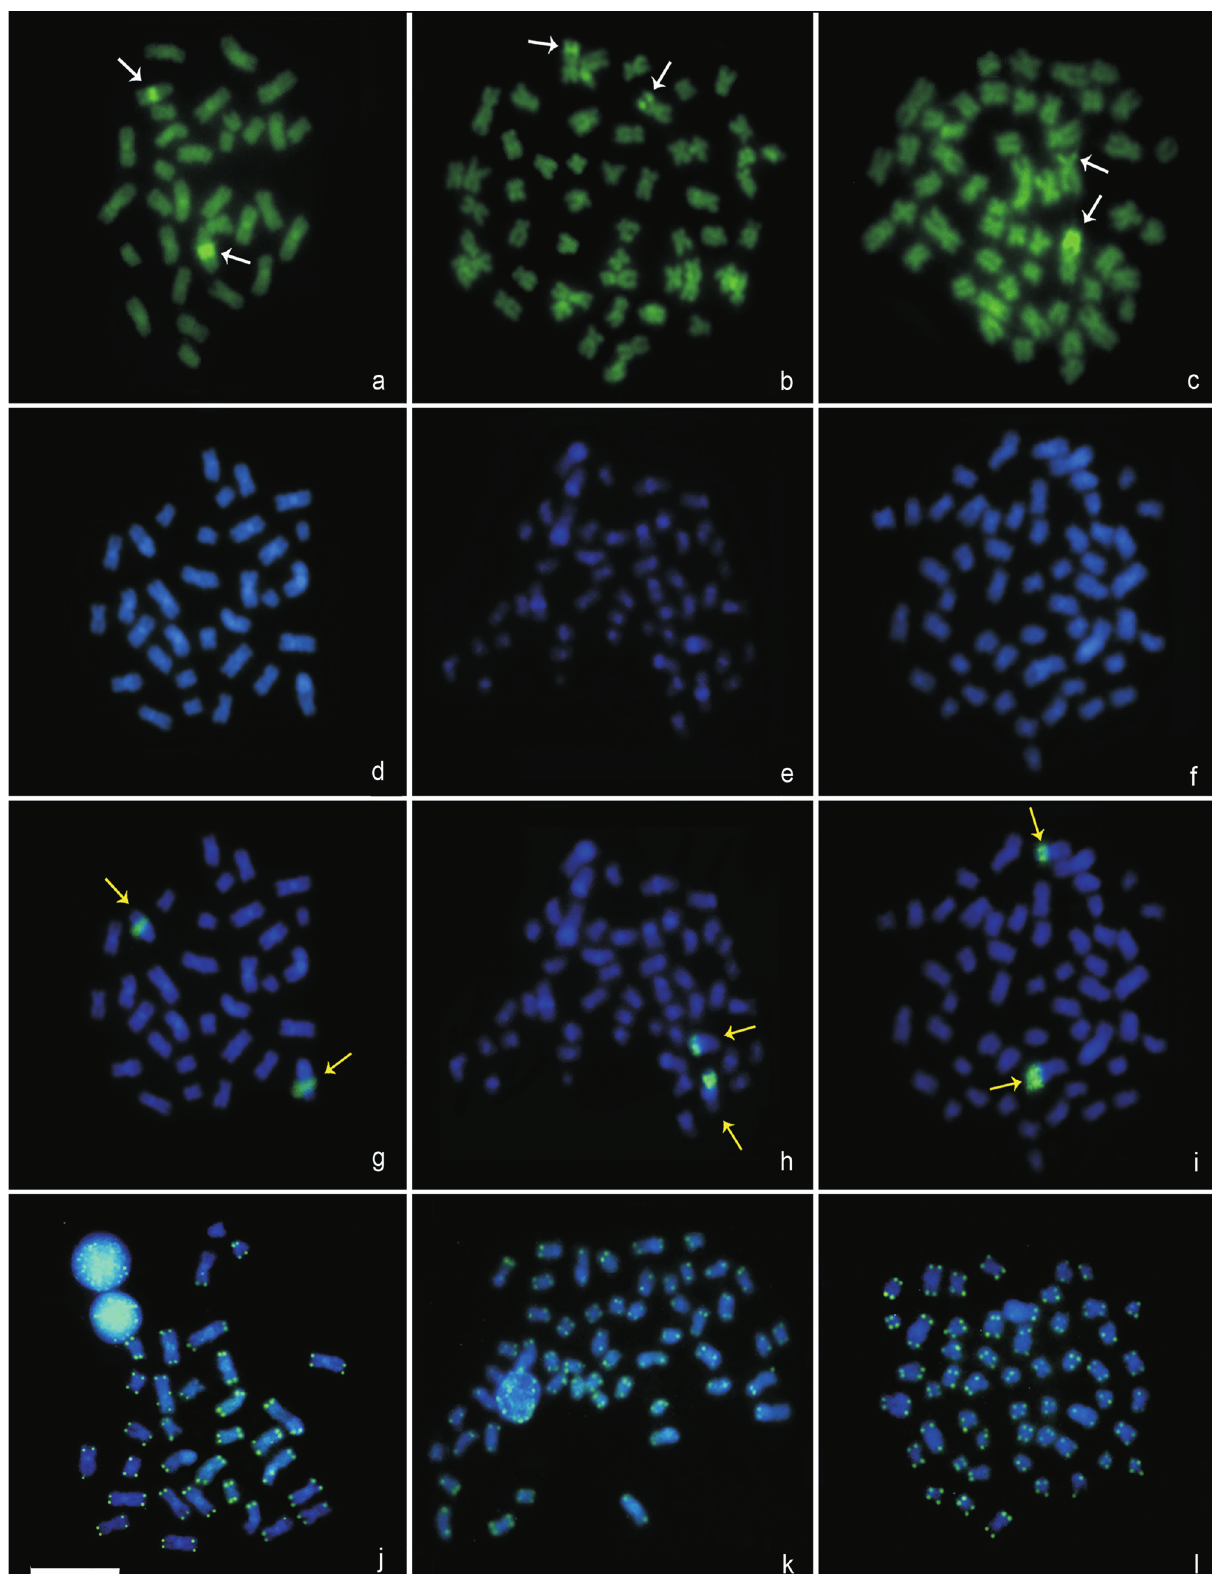
Figure 4 - Fluorescent staining of Sternarchorhamphus muelleri (first column), Parapteronotus hasemani (second column) and Sternarchogiton preto (third column) metaphases, respectively, with CMA 3 (a, b, c), DAPI (d, e, f), 18S rDNA probe (g, h, i), and telomeric probe (j, k, l). White arrows indicate CMA3-marked NORs; yellow arrows indicate NORs marked by 18S rDNA probe. Bar = 5 (cid:2)